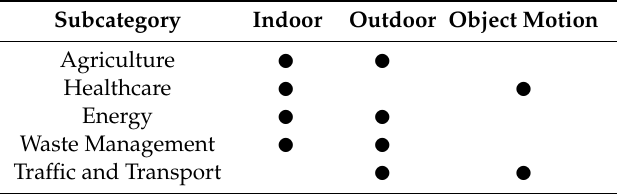
Table 7. Localization of sensors in smart applications.